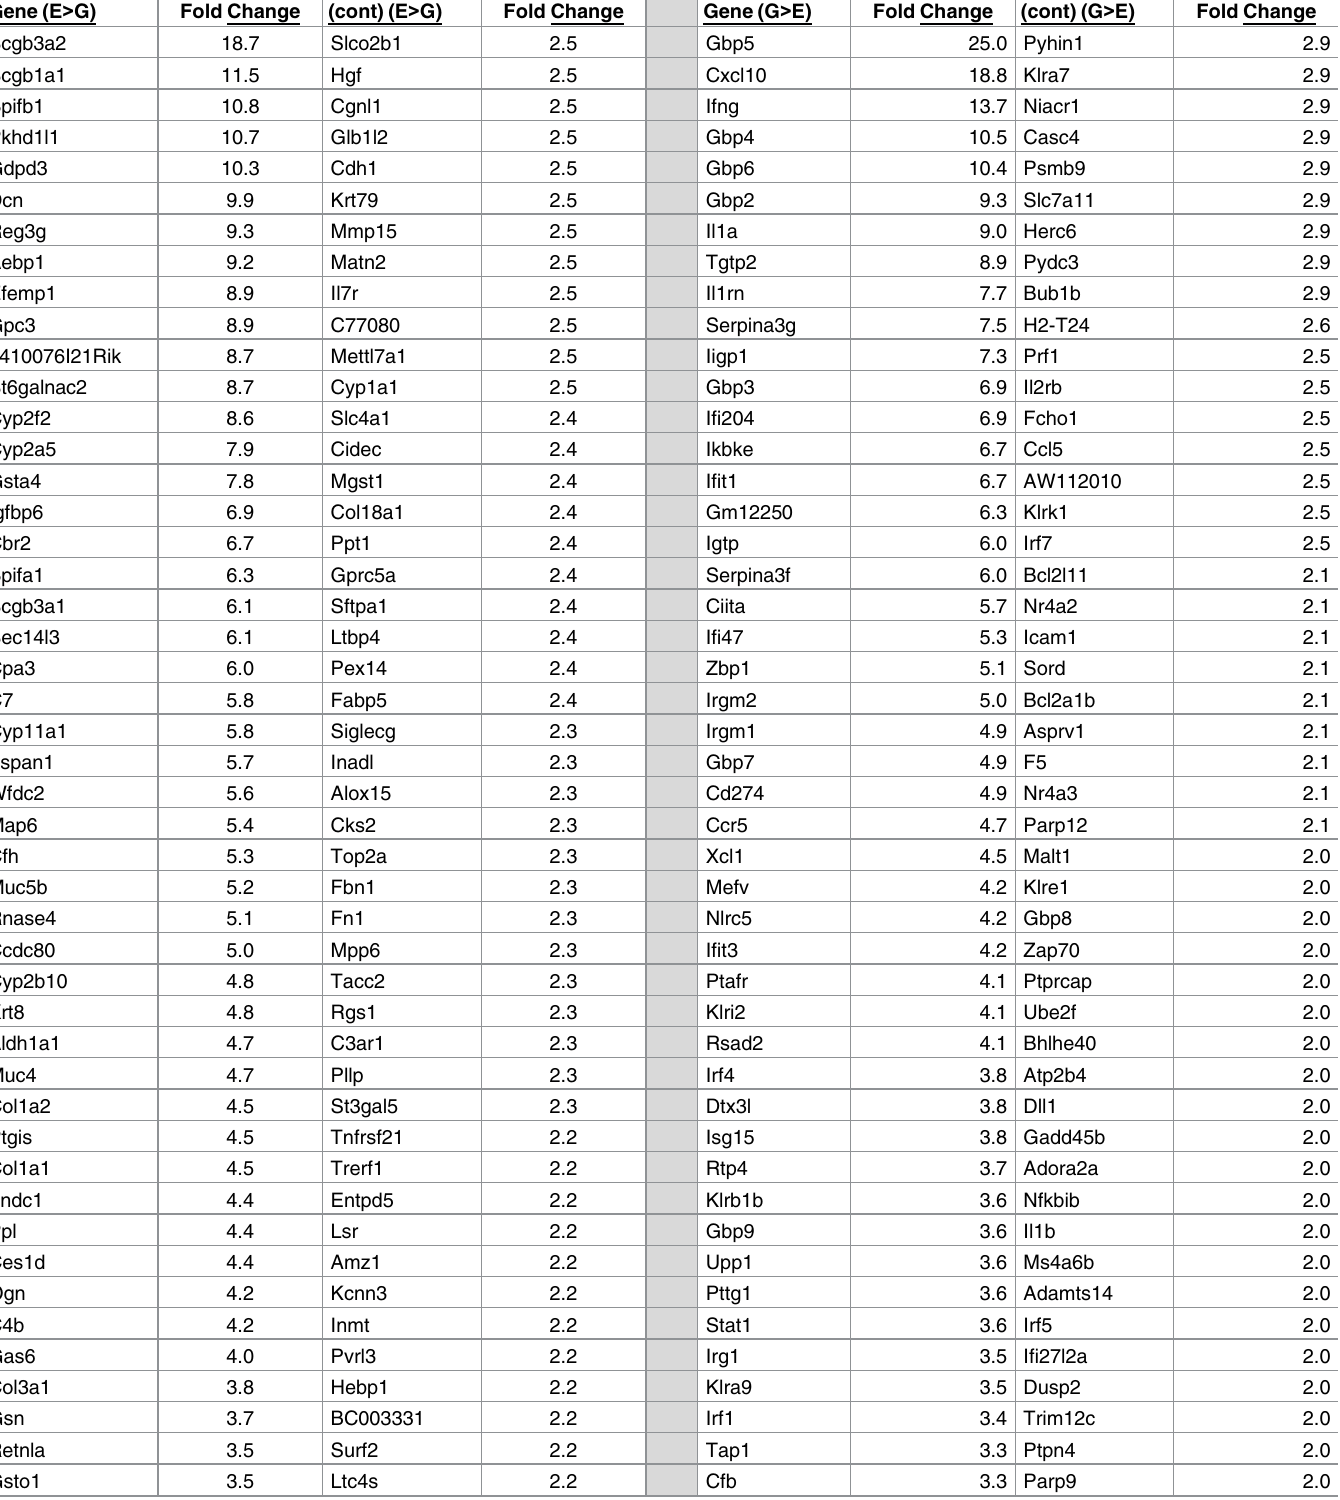
Table 2. LPS α 7 E260A:G versus α 7 G Response Difference (Gene Ratio >